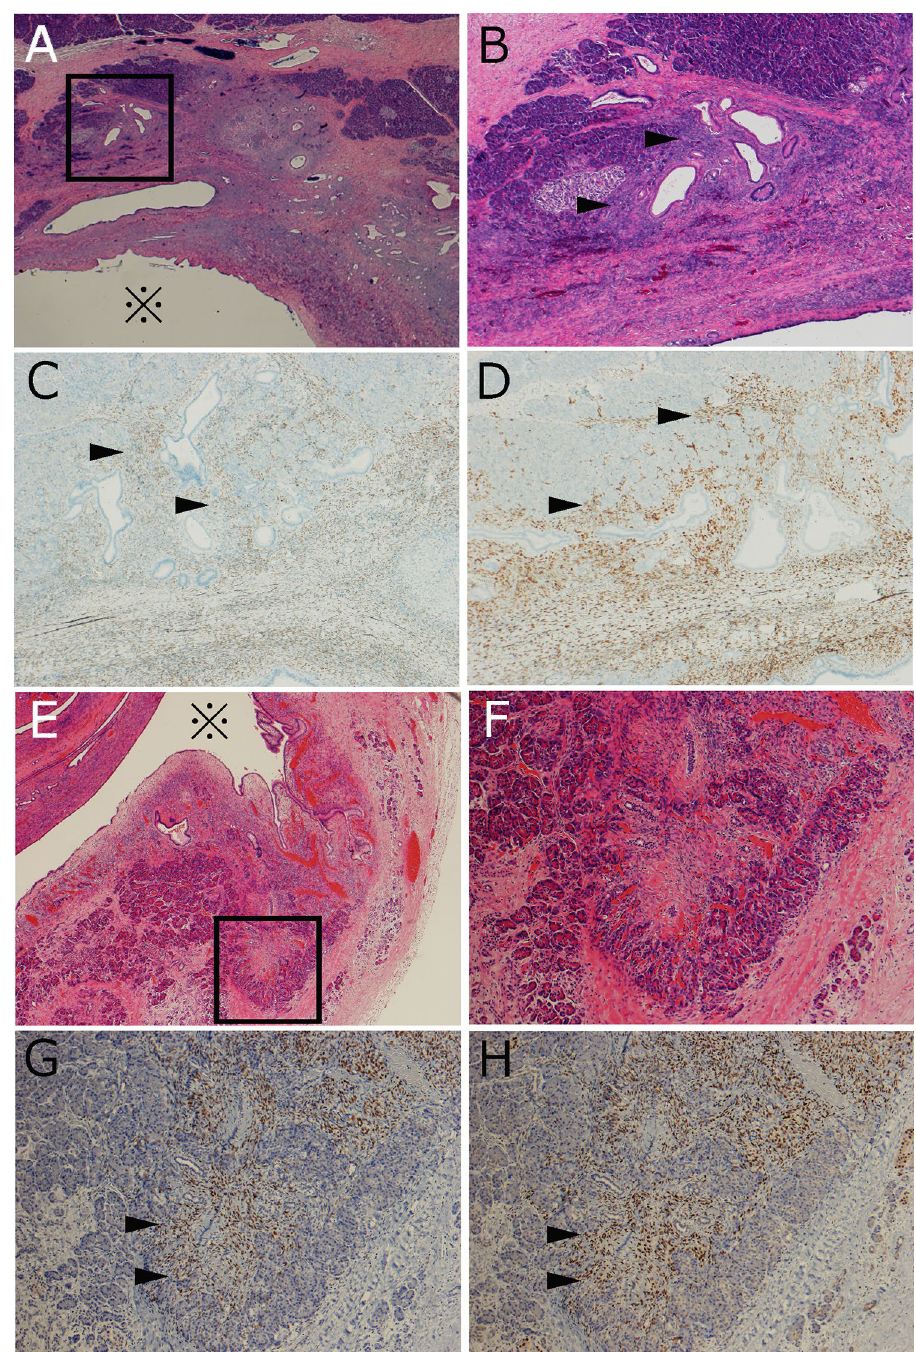
Figure 1. Intralobular distribution of ovalian-like stroma (OLS). ( A – D ) Mucinous cystic neoplasm (MCN) case 1. ( A ) MCN cyst (*) and intralobularly distributed OLS. ( B ) Higher magnification of the square region of 1A. ( C ) ER positivity in OLS. ( D ) PgR positivity in OLS. 1E-H. MCN case 4. ( E ) MCN cyst (*) and intralobularly distributed OLS. ( F ) Higher magnification of the square region of ( E ). ( G ) ER positivity in OLS. ( H ) PgR positivity in OLS. Arrow heads in ( B – D ) and ( F – H ) show intralobular OLS. ( C , G ) Immunohistochemistry for ER. ( D , H ) Immunohistochemistry for